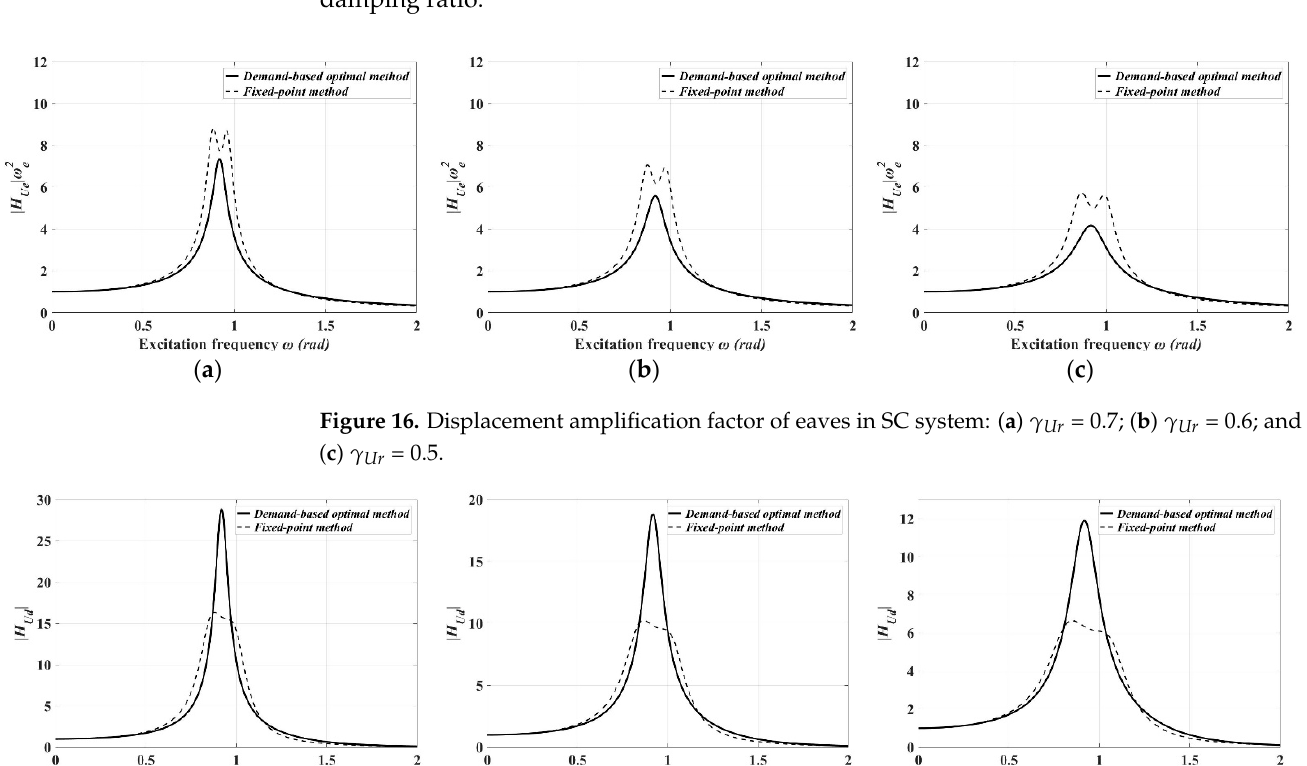
Figure 15. Transfer function curves of relative displacement of grotto-eaves system: ( a ) β = 0; ( b ) β = 0.2; ( c ) β = 1; and ( d ) β = 5.